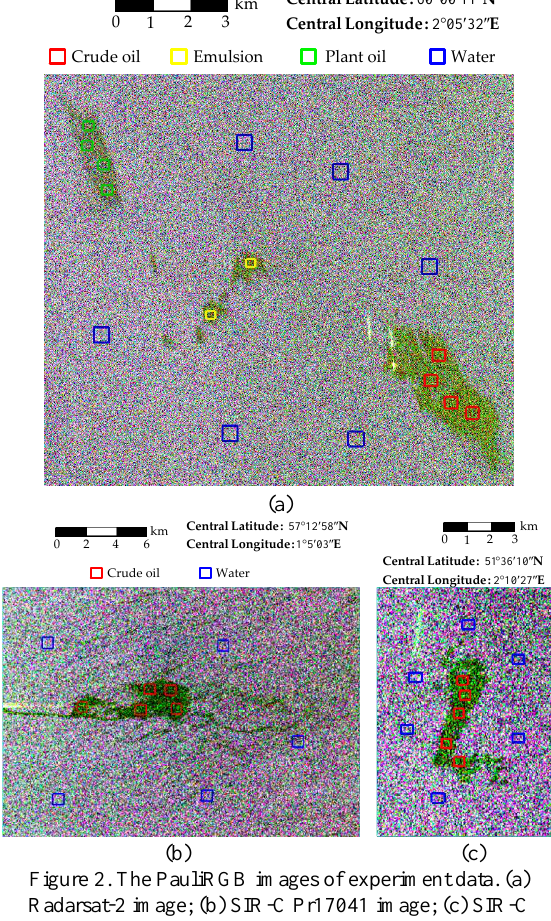
Figure 2. The PauliRGB images of experiment data. (a) Radarsat-2 image; (b) SIR-C Pr17041 image; (c) SIR-C Pr44327 image.